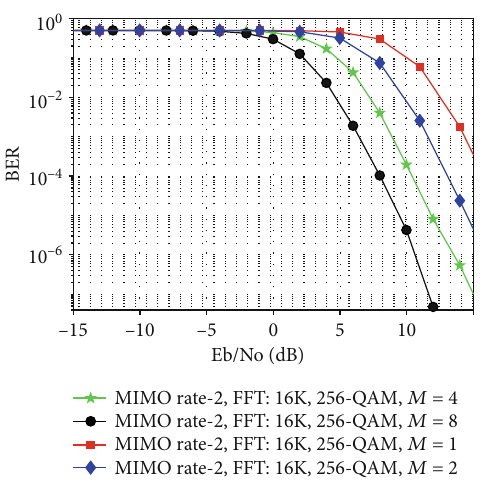
Figure 7: Capacity achieved by various transmitter antennas for a MIMO N s = 4 mode with the modulation scheme of 64-QAM and the inner coding of LDPC